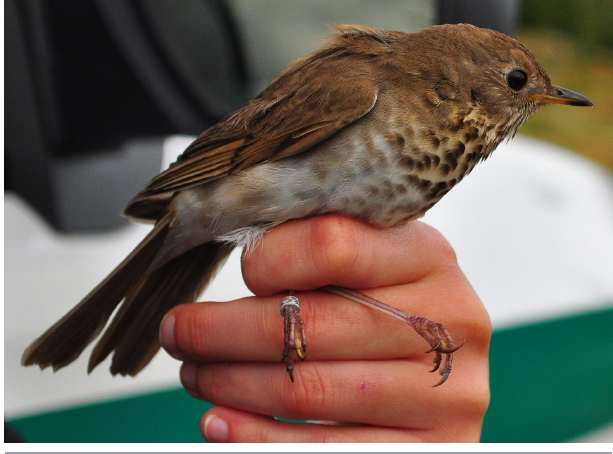
Fig. 1 . Newfoundland Gray-cheeked Thrush (Catharus minimus minimus) banded in the Main River Watershed. C.